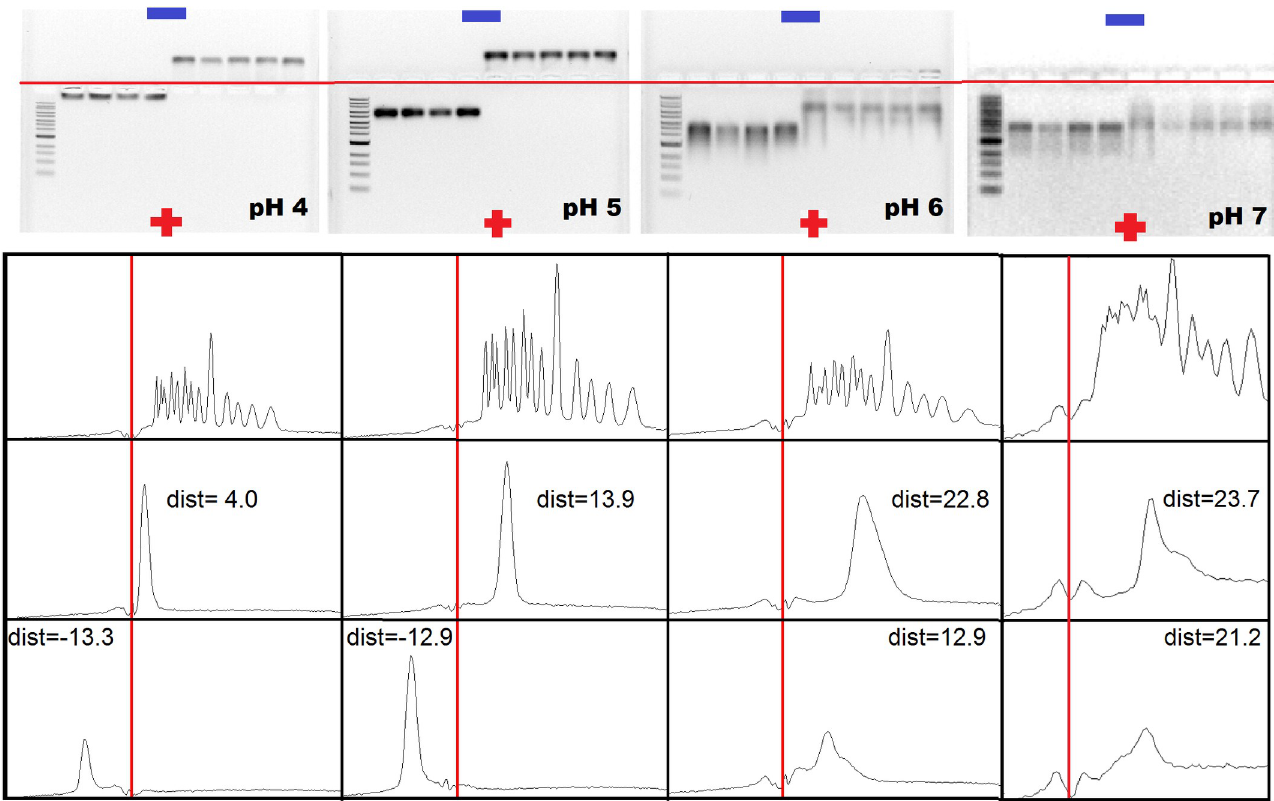
Fig 1. Top. Electrophoretic mobility patterns of CCMV and BMV in 1% agarose gels at pHs 4, 5, 6, and 7 as electrophoresis buffer. In each of the four gels, the samples were loaded as follows: 1-kb-extended DNA ladder (lane 1); CCMV in VSB (pH 4.5), CCMV dialyzed into pH 4, into pH 5, and into pH 6 (lanes 2, 3, 4 and 5, respectively); BMV in VSB (pH 4.5), BMV dialyzed into pH 4, 5, 6 and 7 (lanes 6, 7, 8, 9 and 10, respectively). The red horizontal lines specify the position of the wells. Bottom. Density plots of lanes 1, 2 and 6 to illustrate quantification of the distance that the virus has traveled in each case. The red vertical lines denote the positions of the